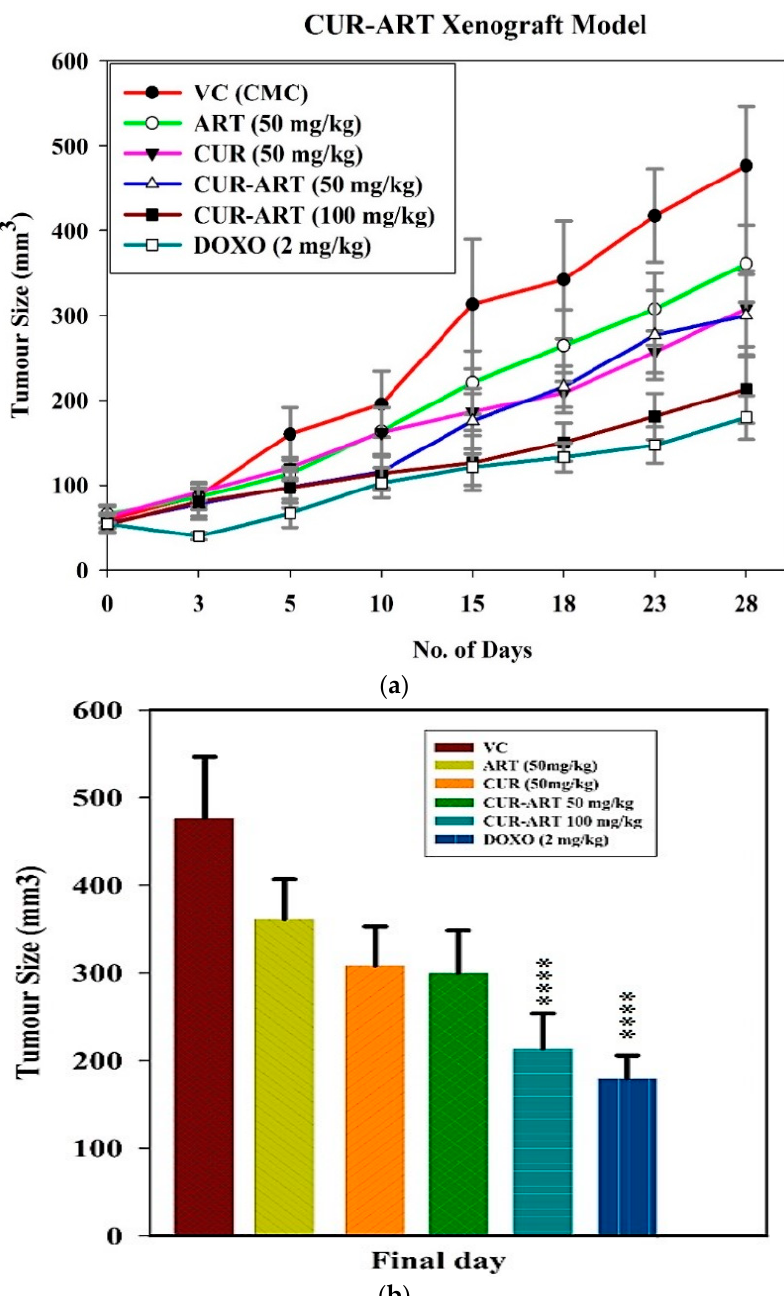
Figure 9. ( a ) Effect of vehicle control (VC), ART, CUR, CUR-ART and doxorubicin (DOXO) on tumor size during the study period; ( b ) Comparison of tumor size on day 28.